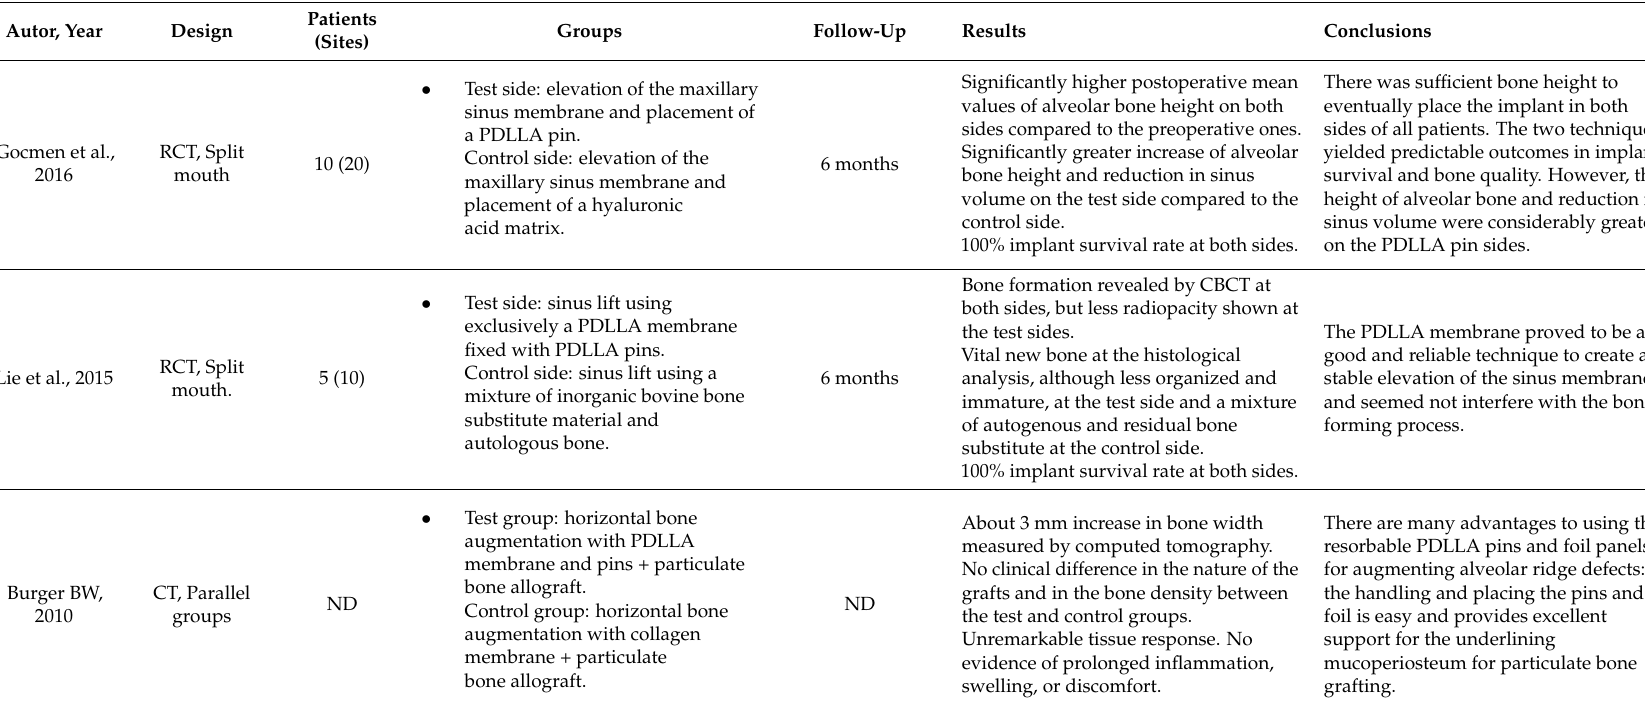
Table 2. Main characteristics of the included articles. RCT: randomized controlled trial; CT: controlled trial; ND: not definable; CBCT: cone beam computed tomography. Autor,